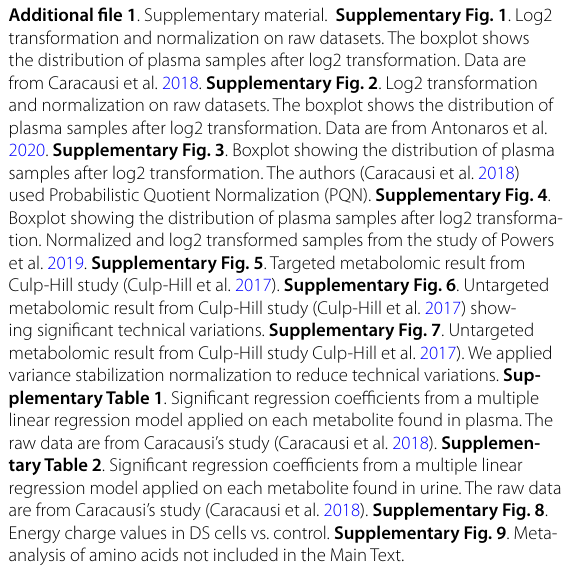
analysis of amino acids not included in the Main